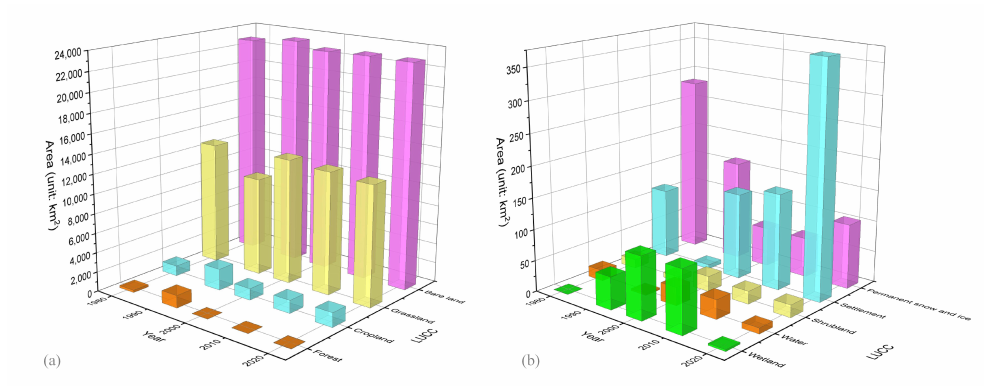
Figure 11. Two histograms. The first histogram ( a ) shows the area of four reclassified land types in the Turpan Basin, including bare land, grassland, arable land, and forest land, from 1980 to 2020. The second histogram ( b ) shows the area of five reclassified land types, including permanent snow and ice, residential areas, shrubs, waters, and wetlands, in the Turpan Basin from 1980 to 2020. According to previous research [57], the population of Turpan has steadily increased from 1985 to 2020, as shown in Figure 12. Therefore, it is reasonable to expect that the areas of cultivated land and built-up land would also steadily increase during this period. This trend is consistent with the observed changes in land use/land cover types in the Turpan Basin.